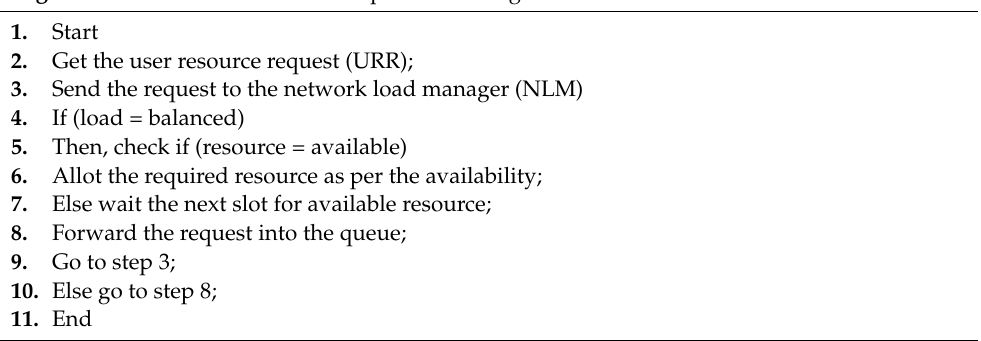
Algorithm 1: Load-based resource optimization algorithm